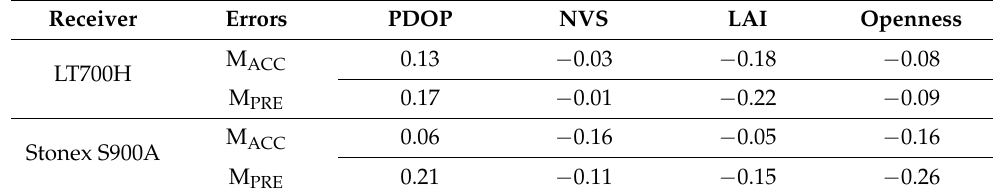
Figure 3. The mean, maximum and minimum accuracy of the LT700H (red color) and Stonex S900A (green color) receivers achieved on all control points during three observation sessions. Table 3. The Pearson correlation coefficient results of forest and navigational metrics for the LT700H and Stonex S900A